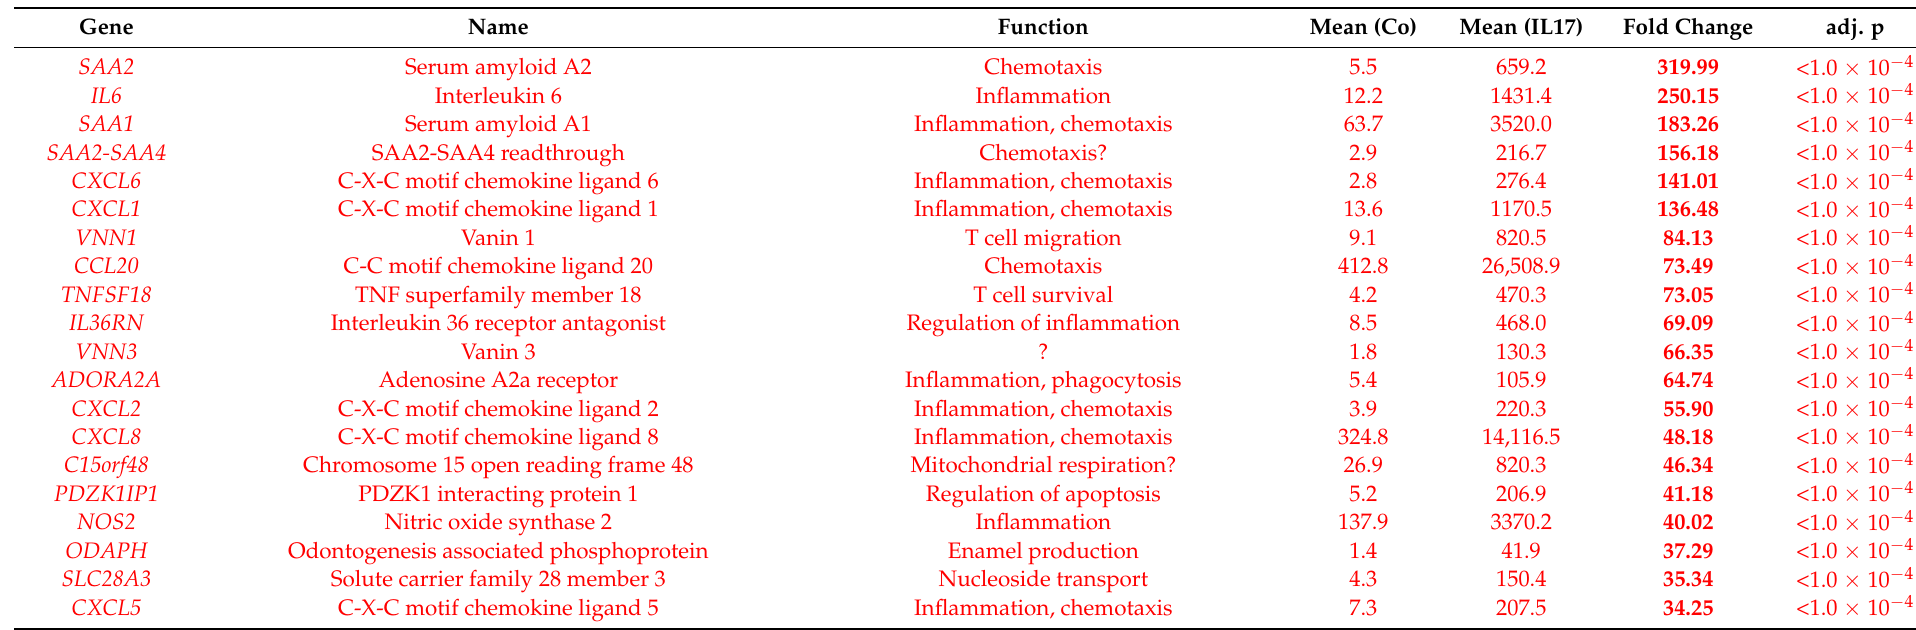
Table 2. Twenty most strongly up- and downregulated genes in interleukin 17-treated OA chondrocytes (IL17) relative to control